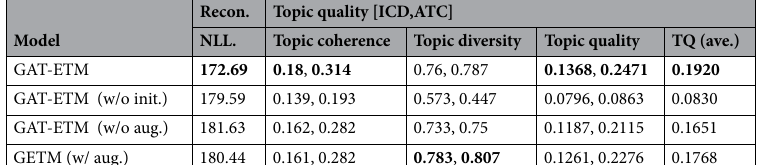
Recon. Topic quality [ICD,ATC] Model NLL. TQ